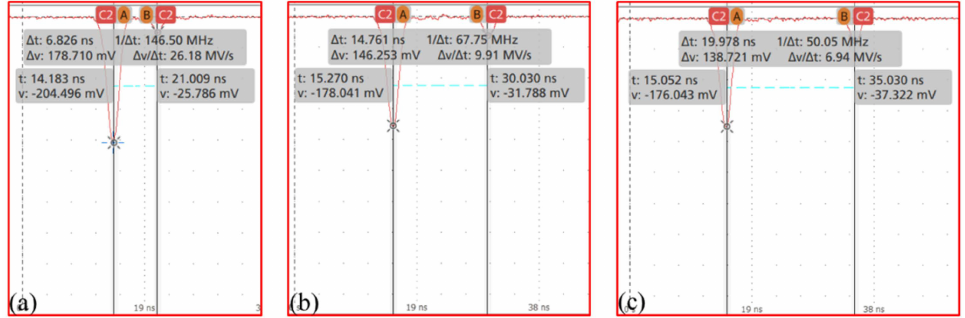
Figure 21. ( a – c ) The waveforms are shown by oscilloscope in indoor experiments; the first peak of the waveforms is the surface signal and the second peak of the waveforms is the bottom